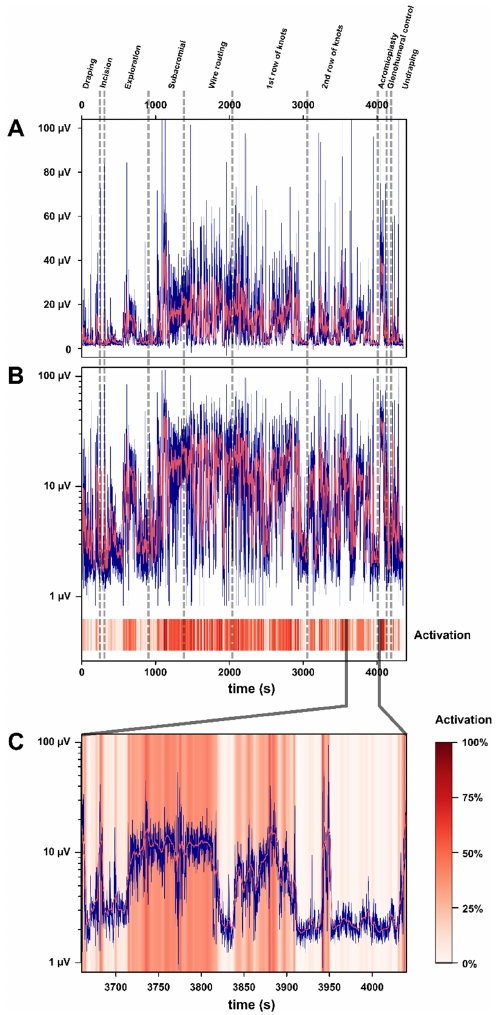
Figure 2. Illustration of the passage from raw EMG signal to intelligible activation signal. ( A ). Fil- tered EMG signal of the right upper trapezius (blue line) in µV during the whole surgical-procedure recording (0 to 4380 s, x -axis). The moving-average-smoothed signal is also shown (red line, win- dow: 5 s). The different surgery sequences are marked as vertical dashed lines. ( B ) The same filtered EMG signal from the right upper trapezius sensor is shown in logarithmical scale (from 1 µV to 100 µV) for the whole duration of the surgical-procedure recording. Corresponding activation signal